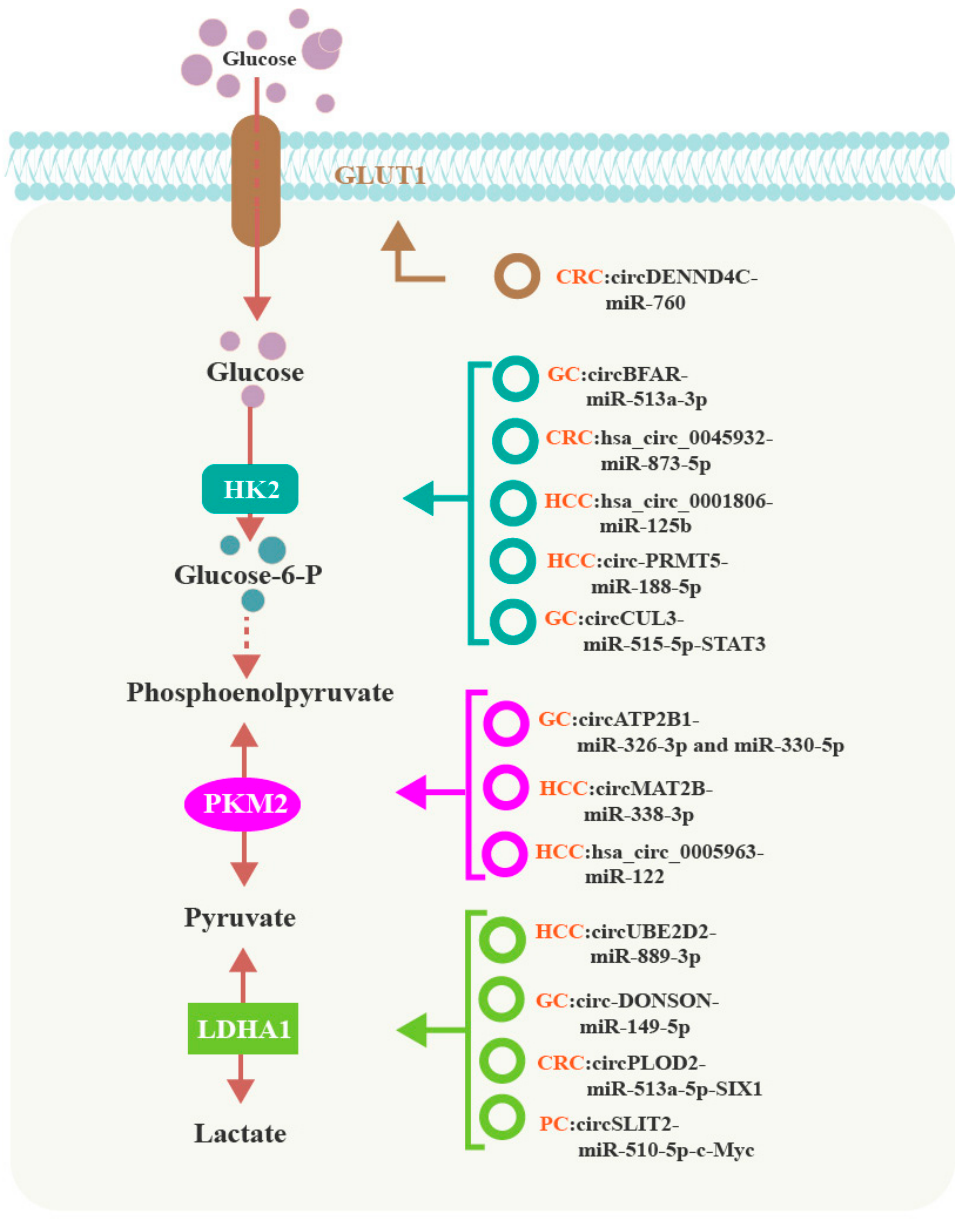
Figure 2. CircRNAs regulate the transcription or expression of GLUT1, HK2, PKM2, and LDHA1 to reprogram glucose metabolism in GI cancers.